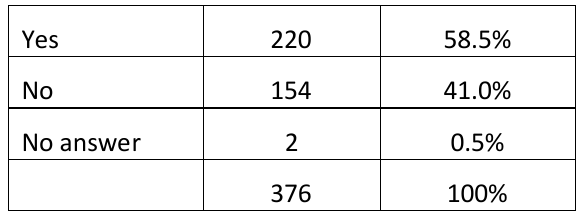
Table 11 : Use in the last two years of data available from publicly accessible